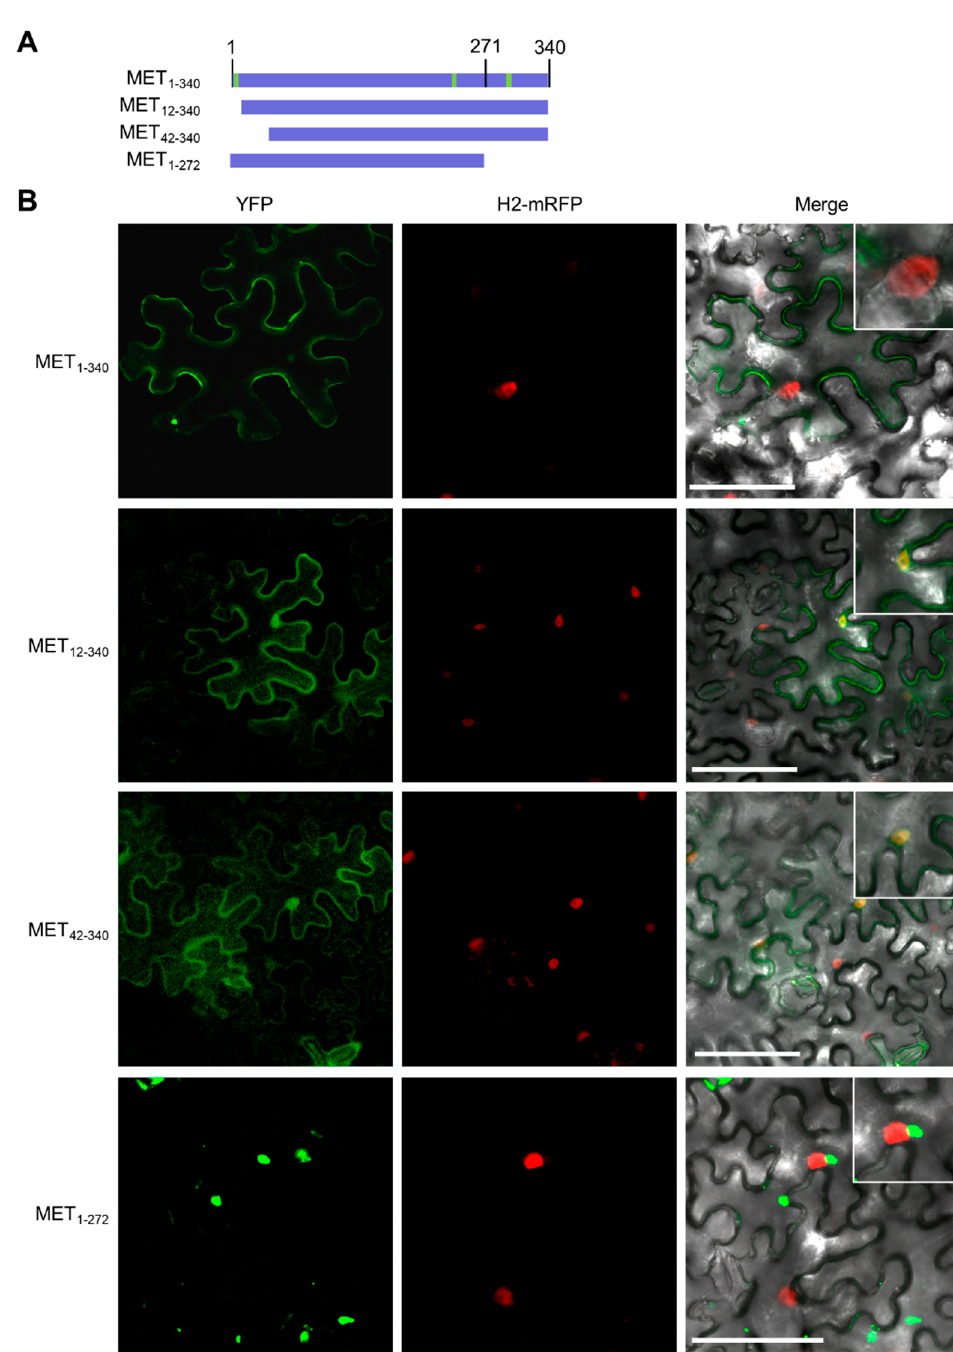
Figure 3. The first α -helix is required for membrane-association. ( A ) Illustration of MET 1-340 mutants. The three putative membrane-association motifs in MET 1-340 are highlighted in yellow. ( B ) Confocal microscopic photos of N. benthamiana epidermal cells expressing MET 1-340 -YFP, MET 12-340 -YFP, MET 42-340 -YFP, and MET 1-272 -YFP at 2 dpi. The nucleus was labeled by H2-mRFP. Insets show the typical nuclear signal. Scale bars = 50 μ m.